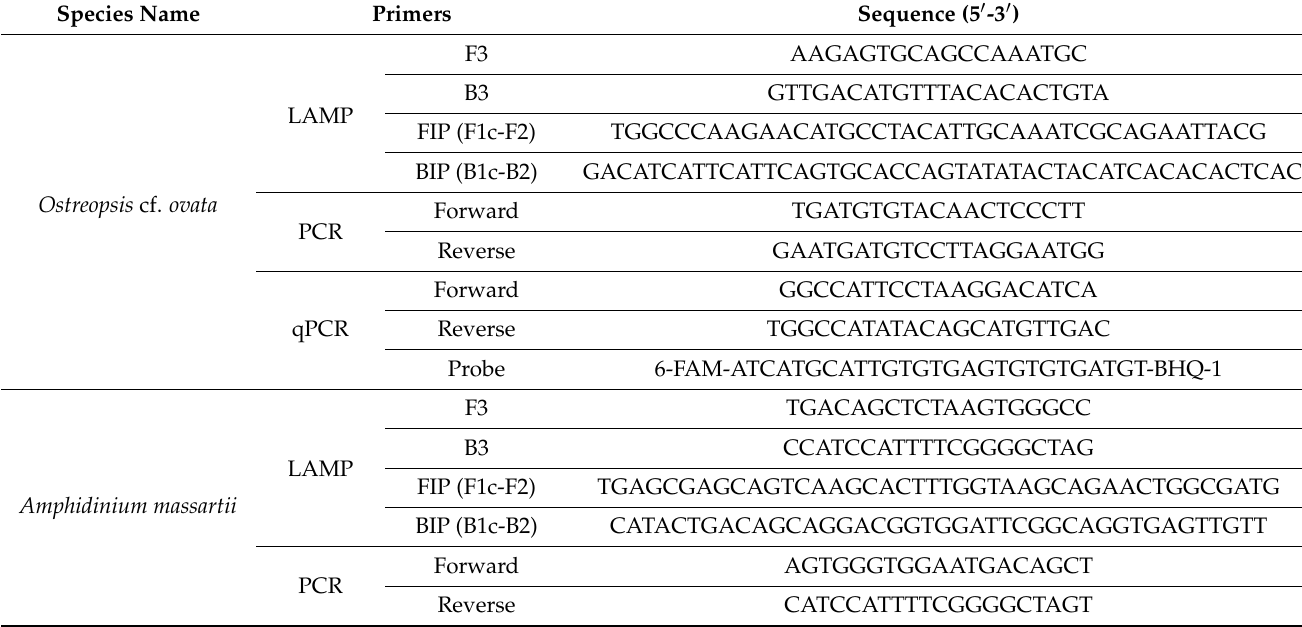
Table 1. Oligonucleotide primers developed for detecting Ostreopsis cf. ovata and Amphidinium massartii using loop-mediated isothermal amplification (LAMP), PCR, and